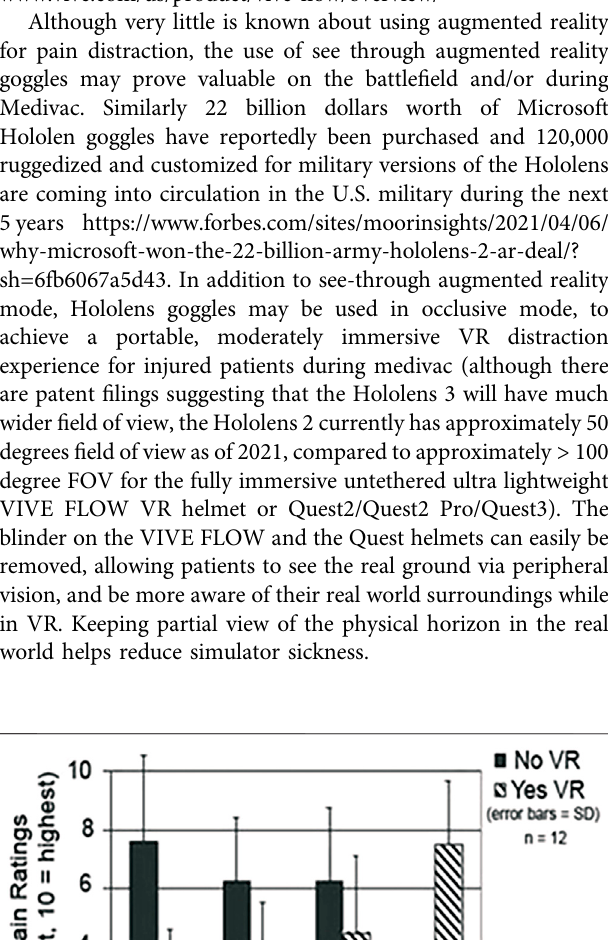
Frontiers in Virtual Reality |